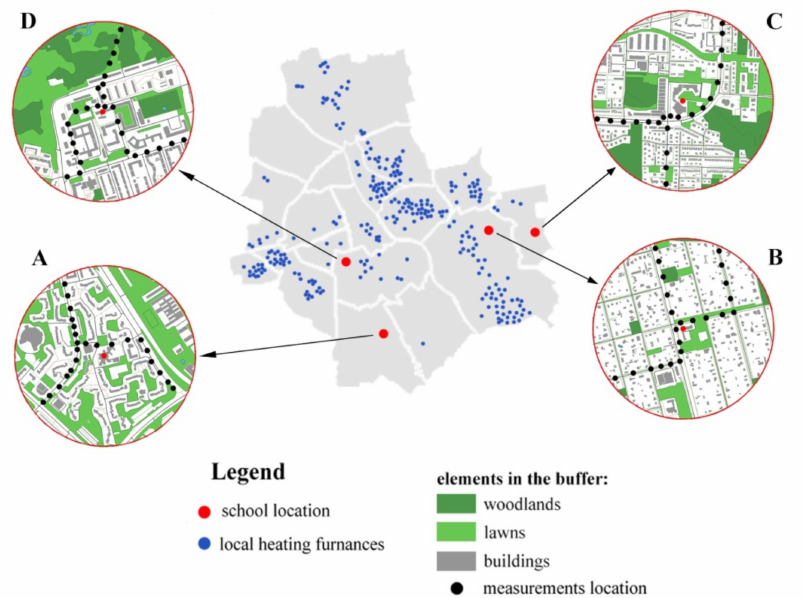
Figure 1. Location of the selected schools and the examined routes and study plots. Examined